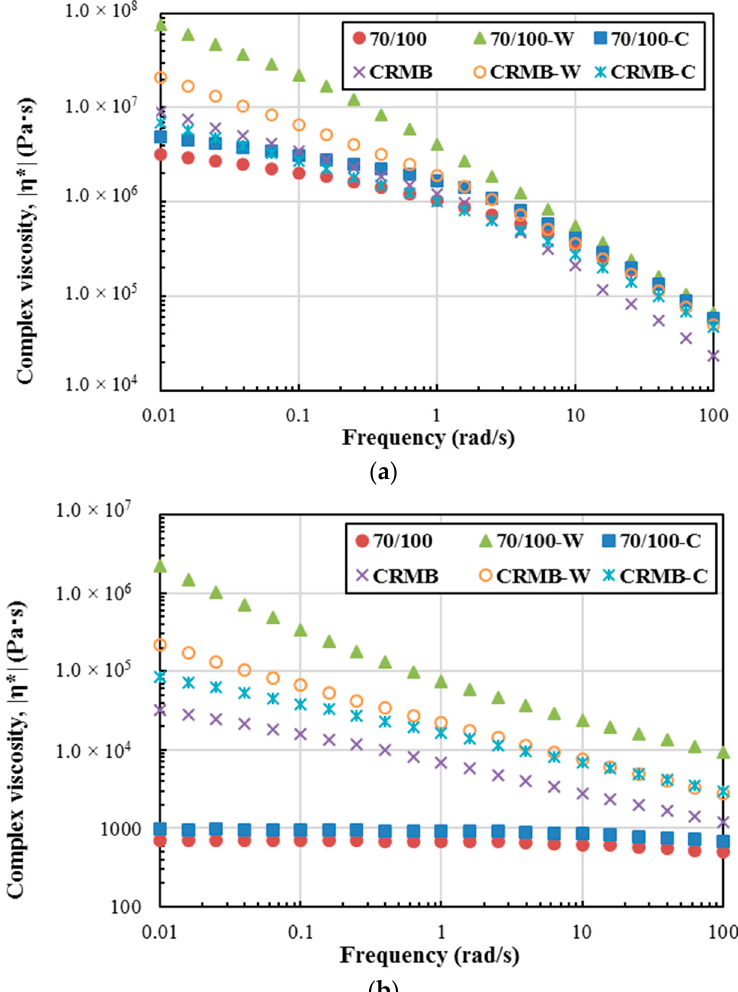
Figure 3. Complex viscosity as a function of shear rate ( a ) at 10 °C; ( b ) at 50 °C.